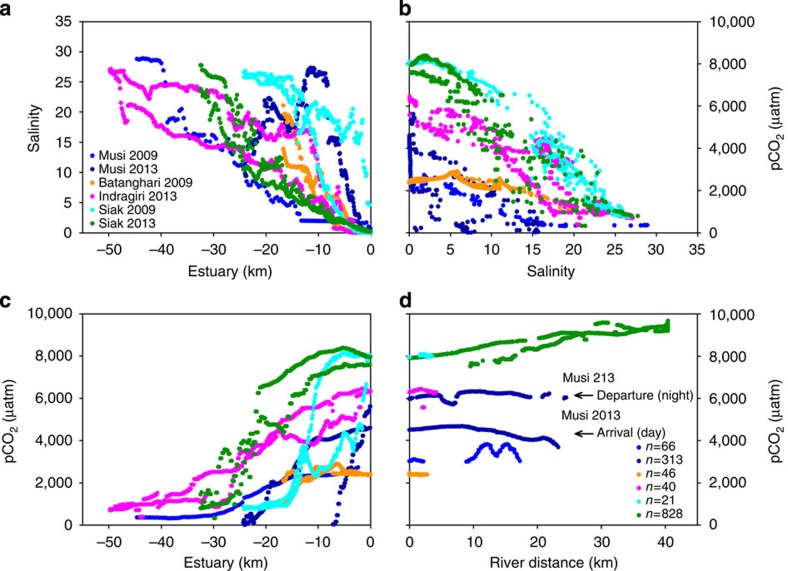
Patterns of salinity and pCO2 underway measurements on the way in and out of the estuaries and rivers in 2009 and 2013.Estuaries start at 0 km, which is the border with the river at salinity zero, with increasing (negative) distance towards the coastal ocean. Measurements in the rivers start at 0 km at salinity <0.1 with increasing distance upstream. (a) Decrease of salinity across estuary towards river. (b) Inverse relationship of pCO2 versus salinity (>0.1). (c) Increase of pCO2 across estuary towards river. (d) pCO2 data points at zero salinity (0–0.1) against river distance, with number of data points in the lower right corner.